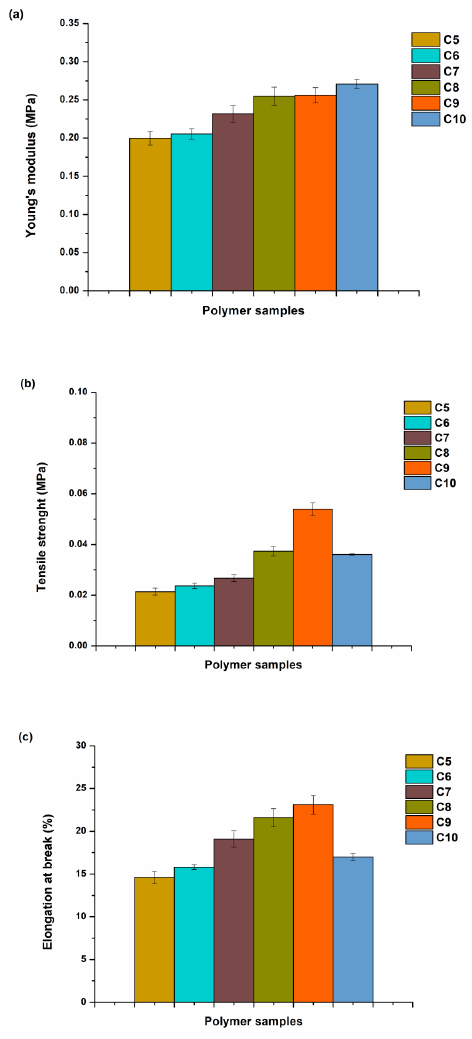
Figure 8. Tensile characteristics of polymers C5 – C10 . ( a ) Young’s modulus, ( b ) tensile strenght, ( c ) elongation at